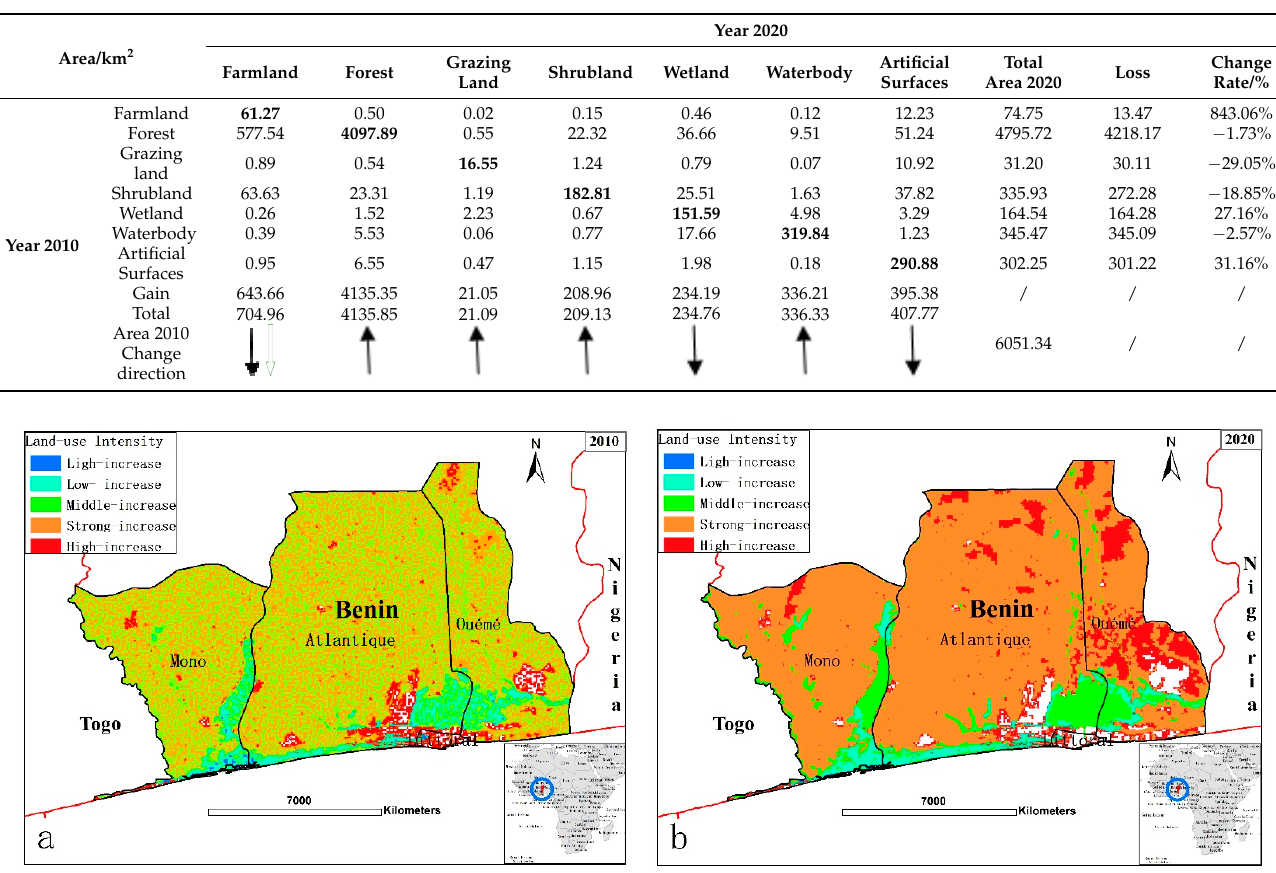
Figure 4. Flow chart of land-use and land cover change directions.